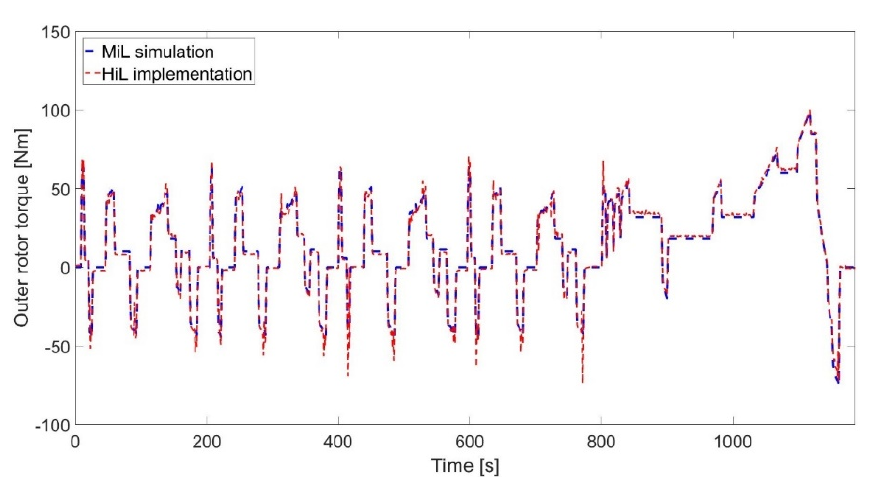
Figure 20. HiL (experimental) vs. MiL agreement results for the outer rotor torque, ECMS-based EMS.